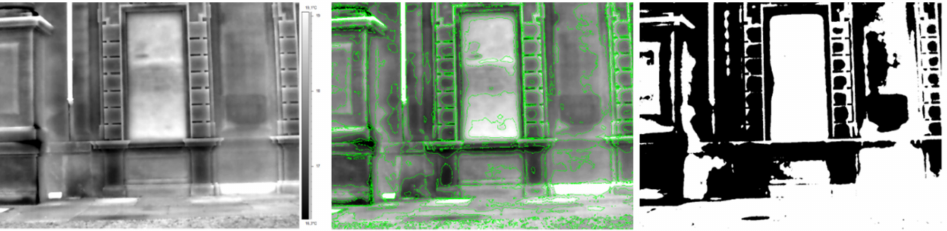
Figure 5. Thermographic image elaboration for Turin’s Castello del Valentino (Italy): ( left ) original thermogram; ( center ) thermal contours (every 0.5 ◦ C); ( right ) thresholded thermogram (at 17.7 ◦